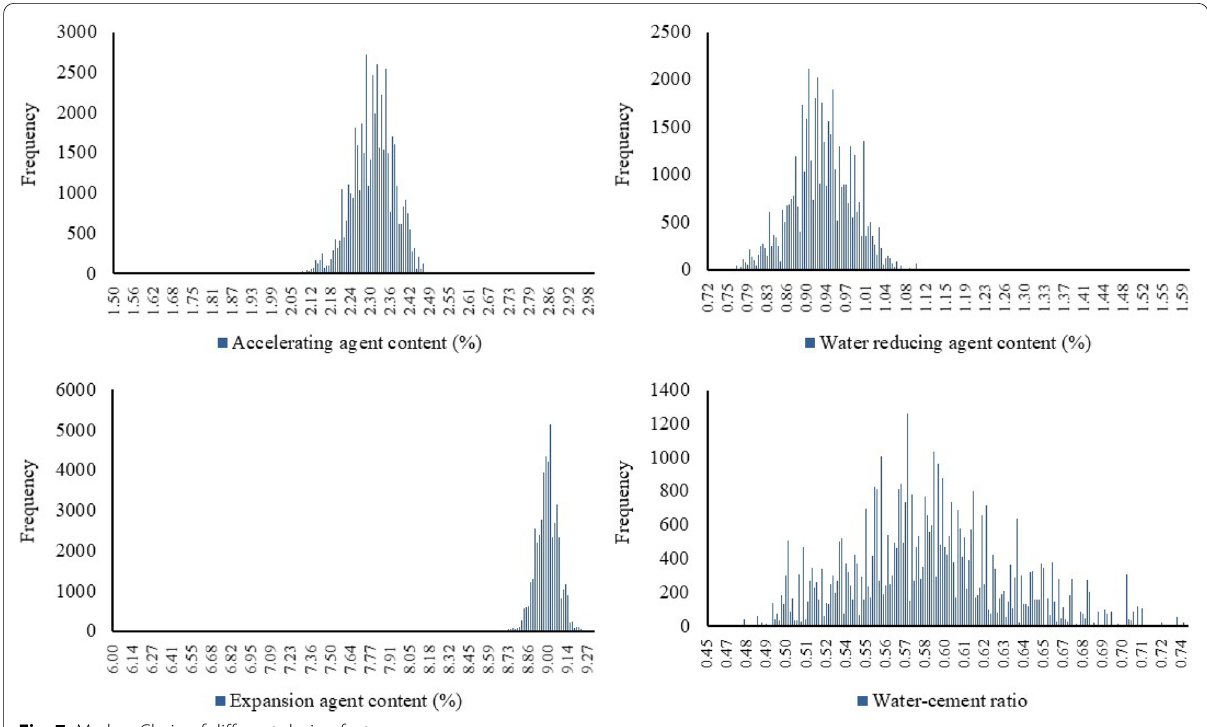
Fig. 7 Markov Chain of different design